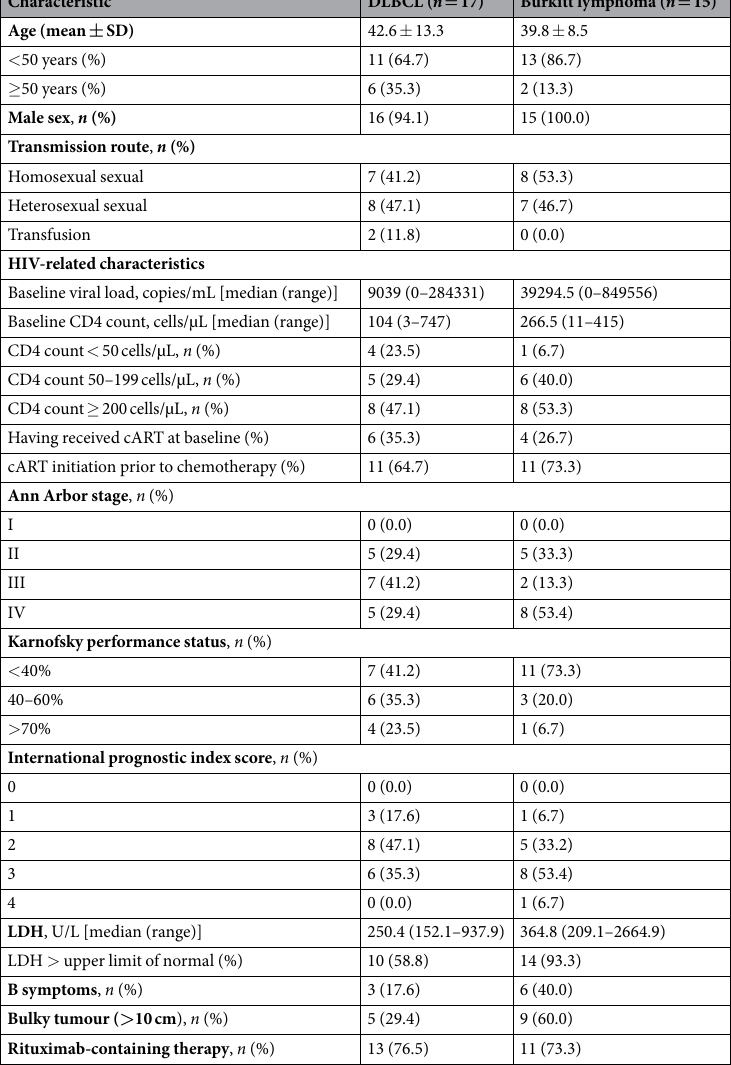
Table 1. Clinical characteristics of HIV-infected patients with lymphoma receiving chemotherapy. HIV, human immunodeficiency virus; DLBCL, diffuse large B-cell lymphoma; SD, standard deviation; cART, combination antiretroviral therapy; LDH, lactate